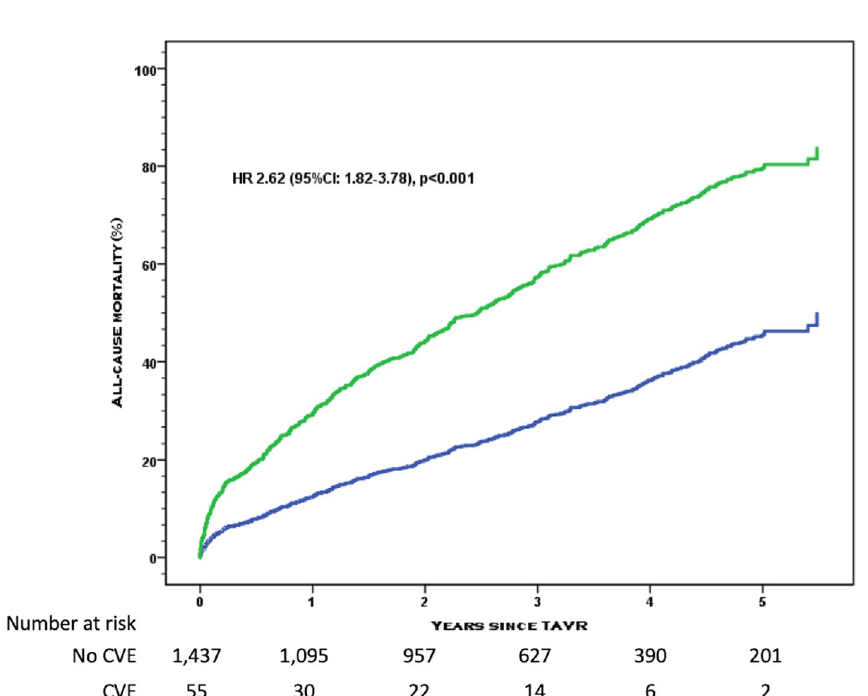
Figure 4. Kaplan–Meier curve of all-cause mortality separated by occurrence of cerebrovascular events within 30 days of